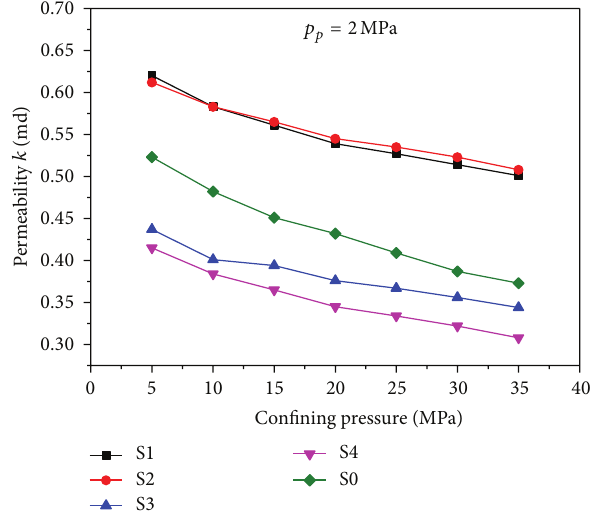
Figure 9: Permeability versus confining pressure at the condition of 𝑝 𝑝 = 2 MPa. S1, S2, S3, and S4 are simulation results; S0 is the experimental